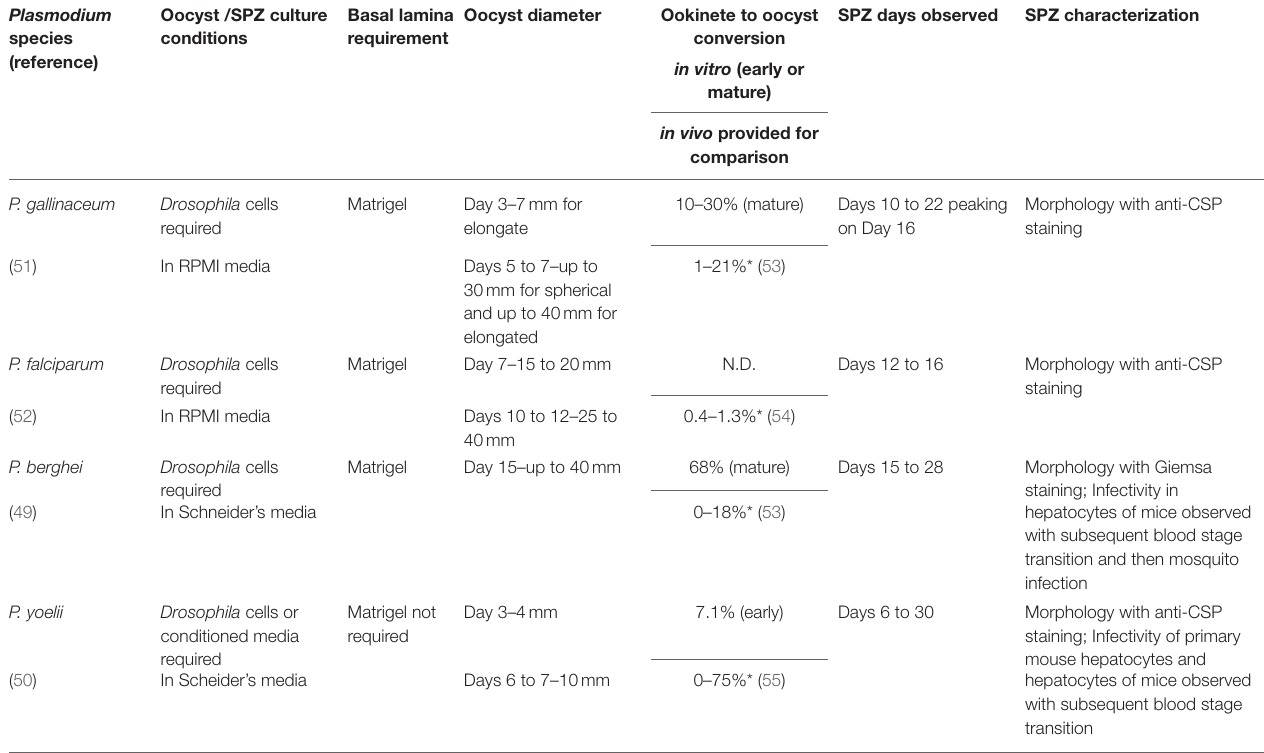
TABLE 1 | Characteristics of in vitro sporozoite culturing systems for Plasmodium gallinaceum , falciparum , berghei and yoelli . Plasmodium